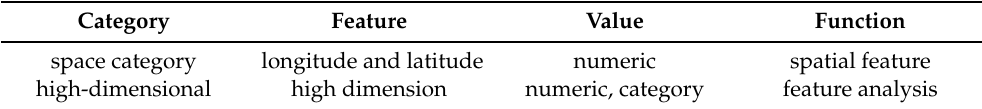
Table 1. Tobacco scientific research spatial data. Category Feature Value Function space category longitude and latitude numeric spatial feature high-dimensional high dimension numeric, category feature